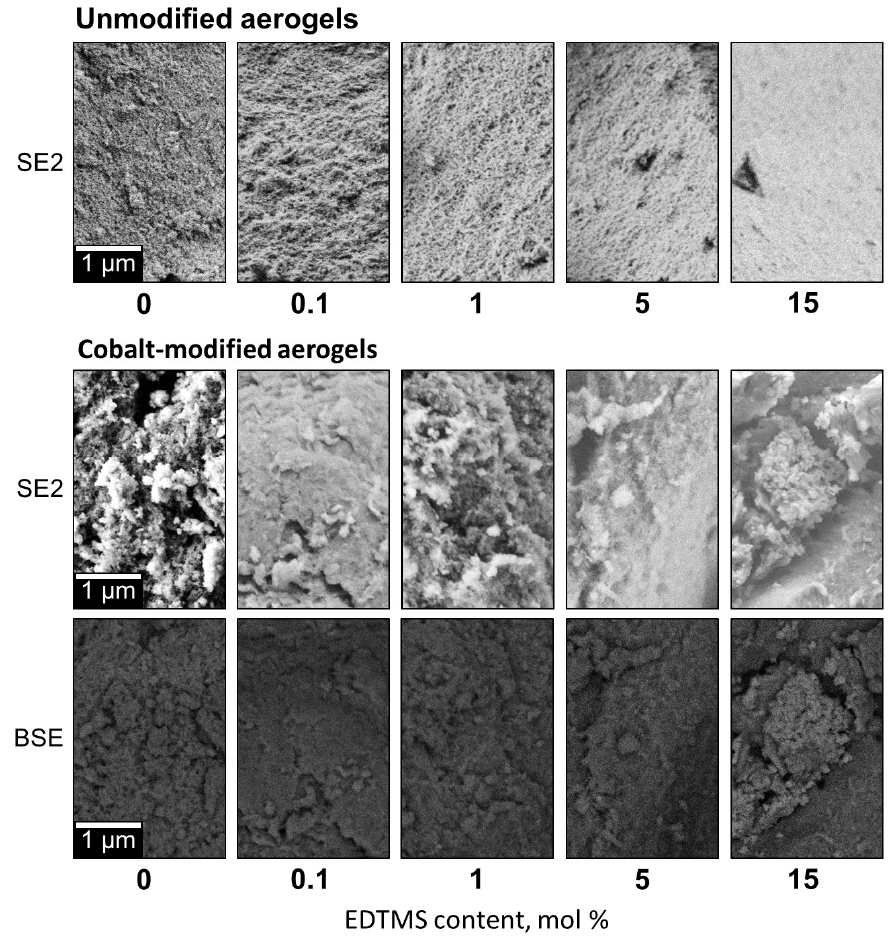
Figure 7. SEM images of the cobalt-modified and bare silica aerogels prepared using various amounts of EDTMS. SE2 and BSE represent the images registered at 1 kV in secondary electrons and back-scattered electrons, respectively.